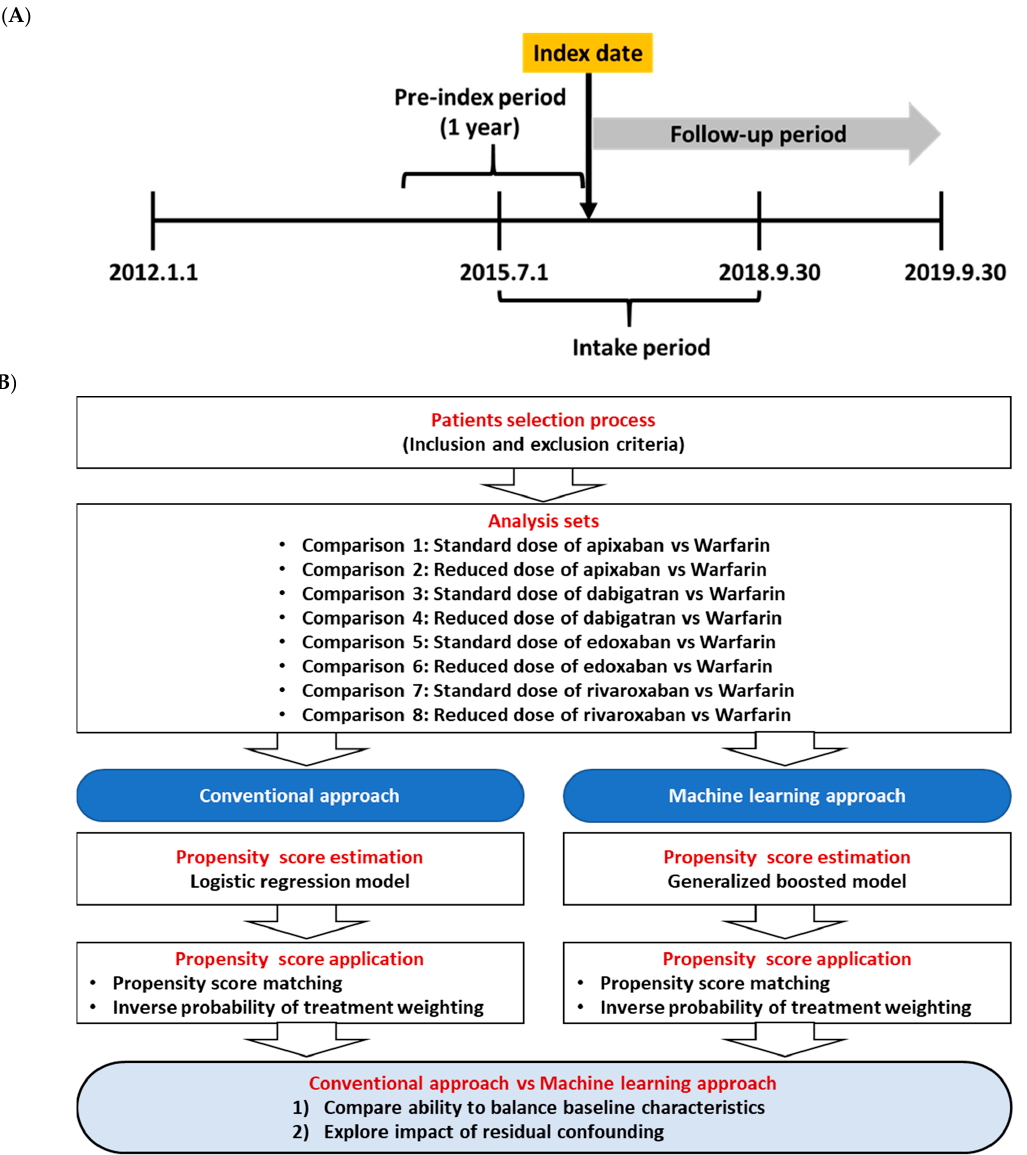
Figure 1. Study scheme. ( A ) Patient selection and follow-up. ( B ) Overall process.